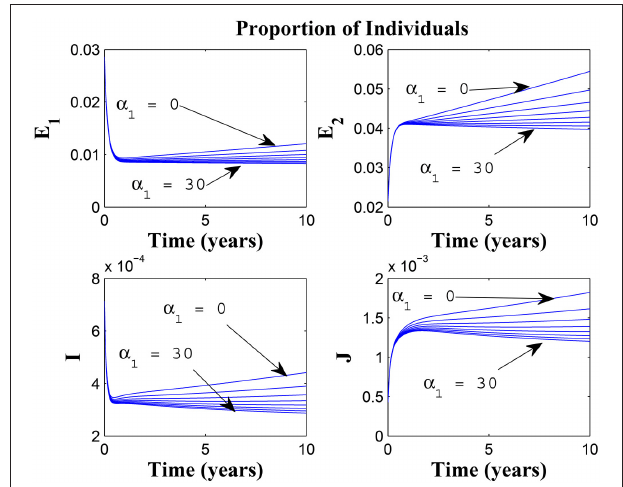
FIGURE 7 | Simulations of model (3) showing the number of infected individuals. Here, the awareness rate for the susceptible individuals ( α 1 ) is varied from 0 to 30 with θ 1 = 20 , θ 2 = 1 and π = 5 .